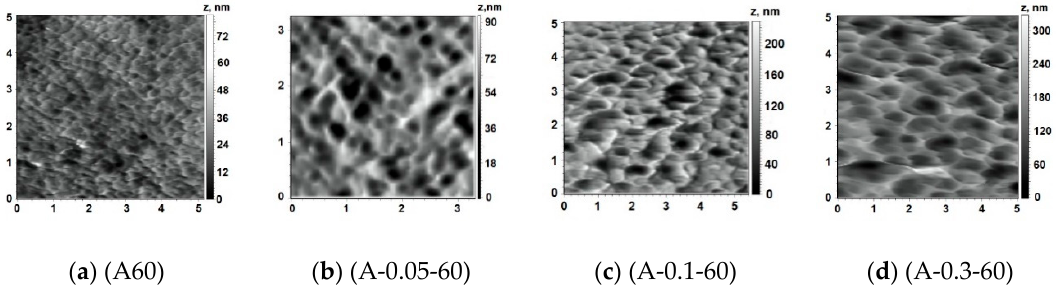
Figure 7. AFM images of the surface of the skin layer, PASA concentration in the coagulant, (T = 60 °C), wt %: ( a ) 0; ( b ) 0.05; ( c ) 0.1; ( d ) 0.3.